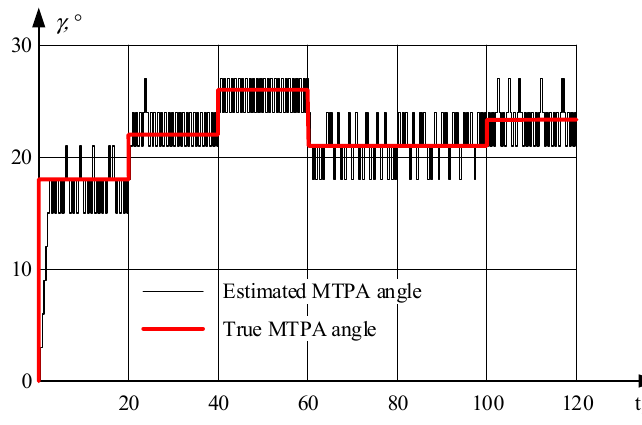
Figure 12. MTPA angle defined at 1500 rpm with N = 30.